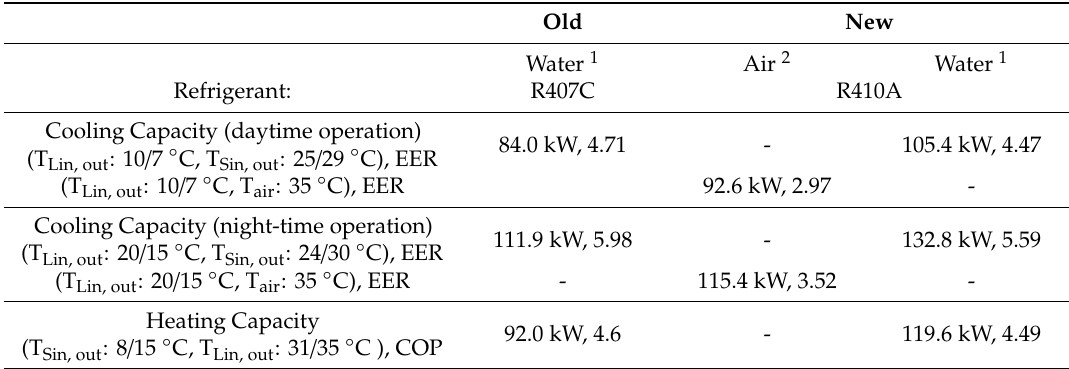
Table 1. Characteristics of the old and new heat